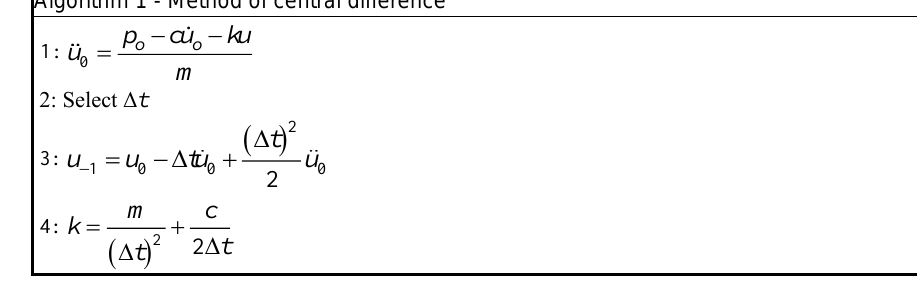
Algorithm 1 - Method of central